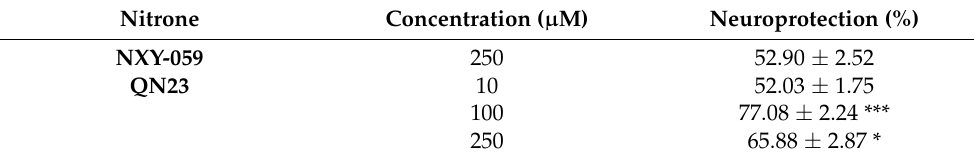
Table 1. Neuroprotective activity of nitrones NXY-059 and QN23 on neuronal cultures after OGD a.